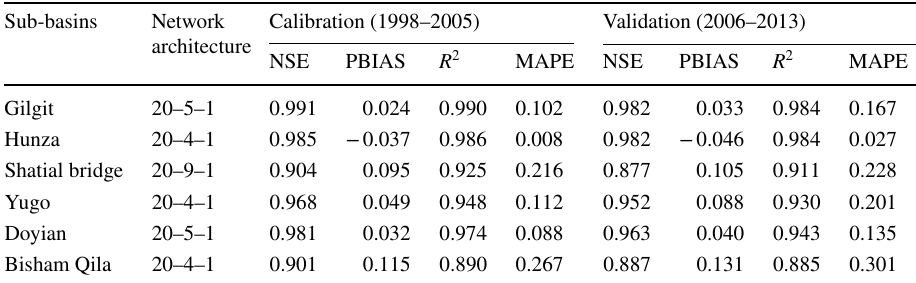
Table 6 Evaluation of MLP model performance in the calibration and validation periods using NSE, PBIAS, R 2 , and MAPE statistical